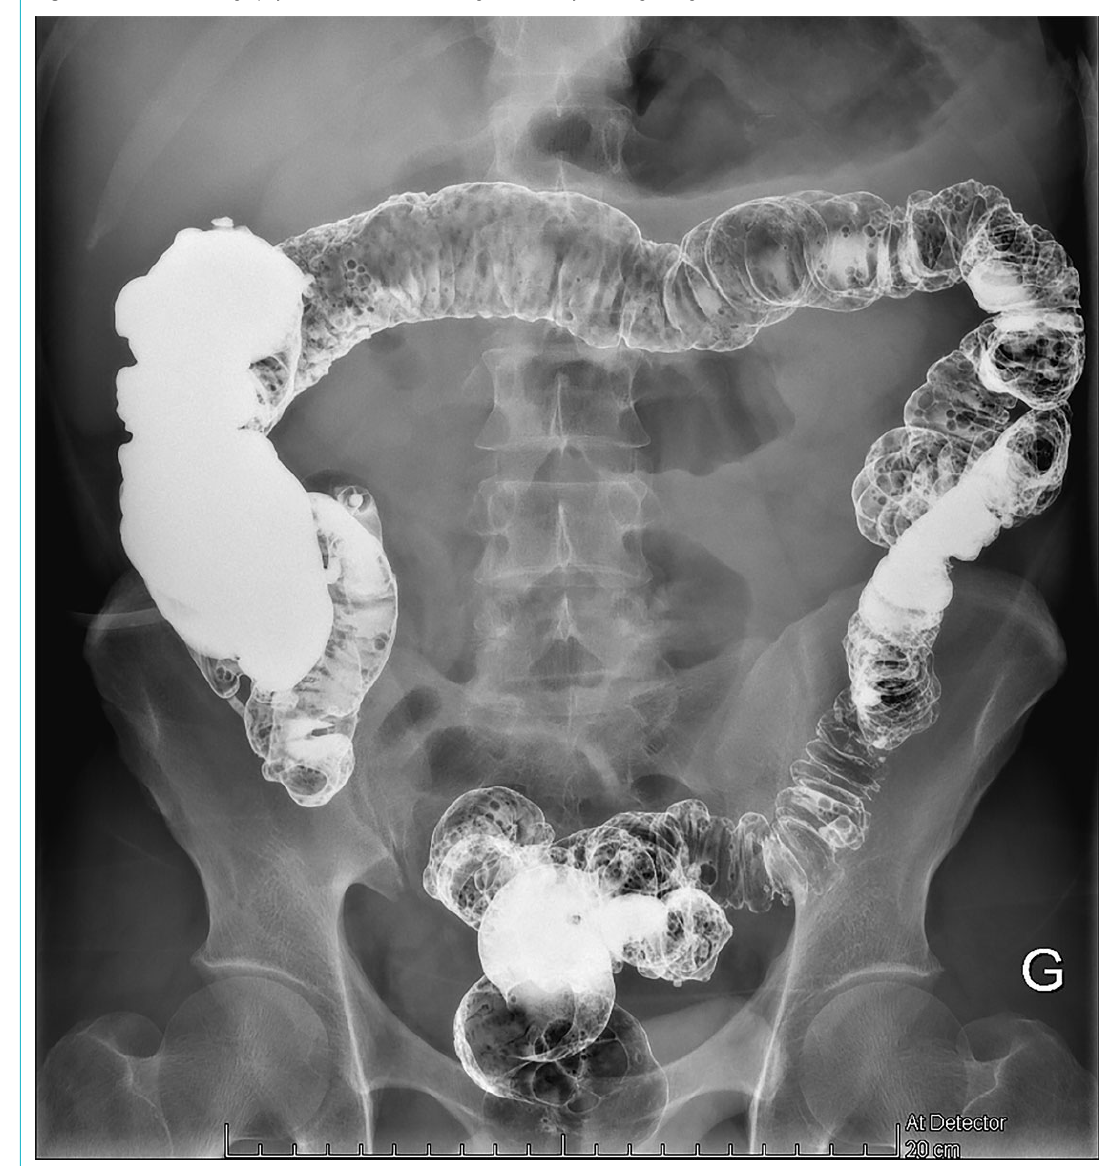
Figure 6: Abdominal radiography with barium enema through the ostomy showing no signs of